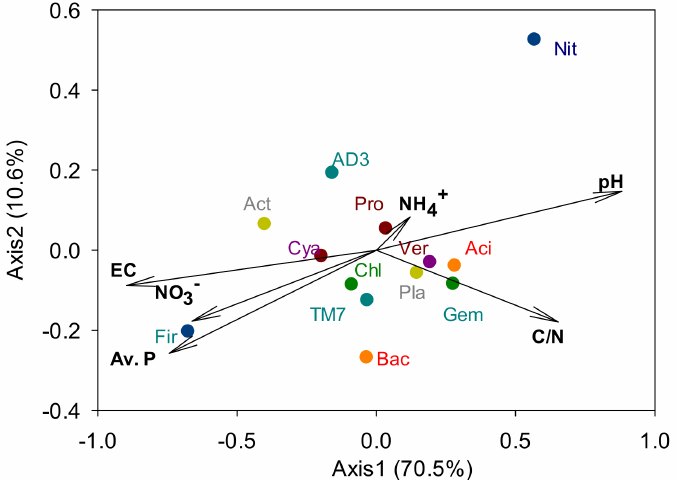
Figure 5. Canonical correspondence analysis between soil chemical properties and dominant bacterial phyla. Aci, Acidobacteria; Act, Actinobacteria; AD3, a candidate division; Bac, Bacteroidetes; Chl, Chloroflexi; Cya, Cyanobacteria; Fir, Firmicutes; Gem, Gemmatimonadetes; Nit, Nitrospirae; Pla, Planctomycetes; Pro, Proteobacteria; TM7, a candidate division; Ver, Verrucomicrobia. The relative abundance of some species only increased with one specific plant commu- nity, and this phenomenon was observed with all five plant communities (Table 4). A total of two OTUs, FJ536874_s and AJ544784_s, comprised up to 10.3% of the relative abundance bacteria in P. pratensis , while FJ466008_s and Sporosarcina soli increased only with P. pratensis , and Parafrigoribacterium mesophilum was found only with A. alba × P. pratense